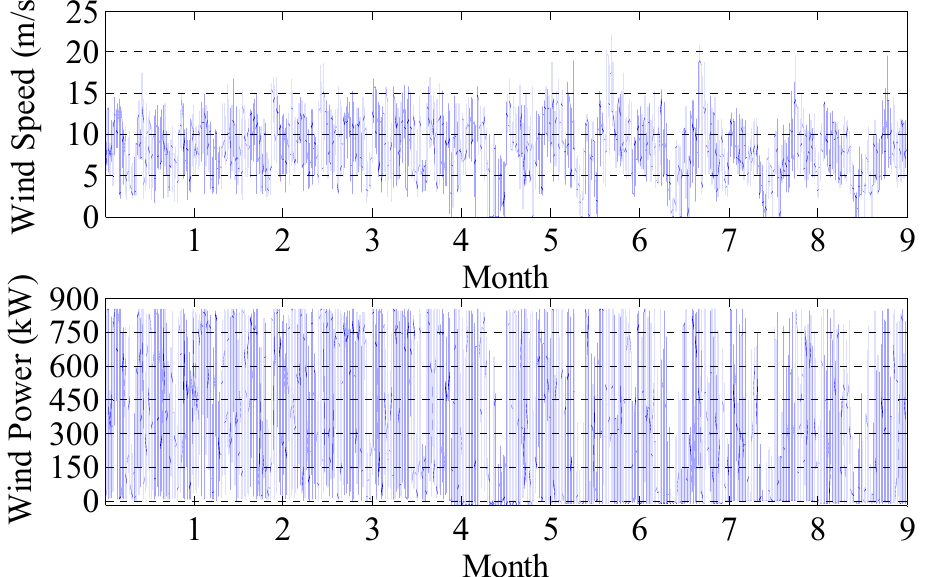
Figure 6. Schematic diagram of wind speed and power fluctuations.